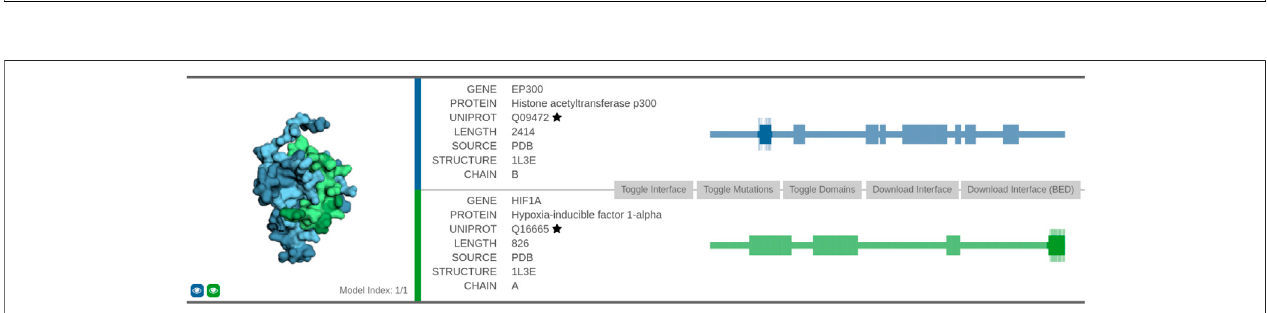
FIGURE 6 | Visualization of the predicted interaction interface as obtained by the Interactome INSIDER tool. The sequential view of the amino acid sequences with theannotateddomaininformation(rectangles)isshownintherightmostpartofthe fi gure.Thesegmentsthatformtheinteractionsurfaceareshownindarkcolor,andthe relevant amino acid residues are represented as vertical lines along the highlighted